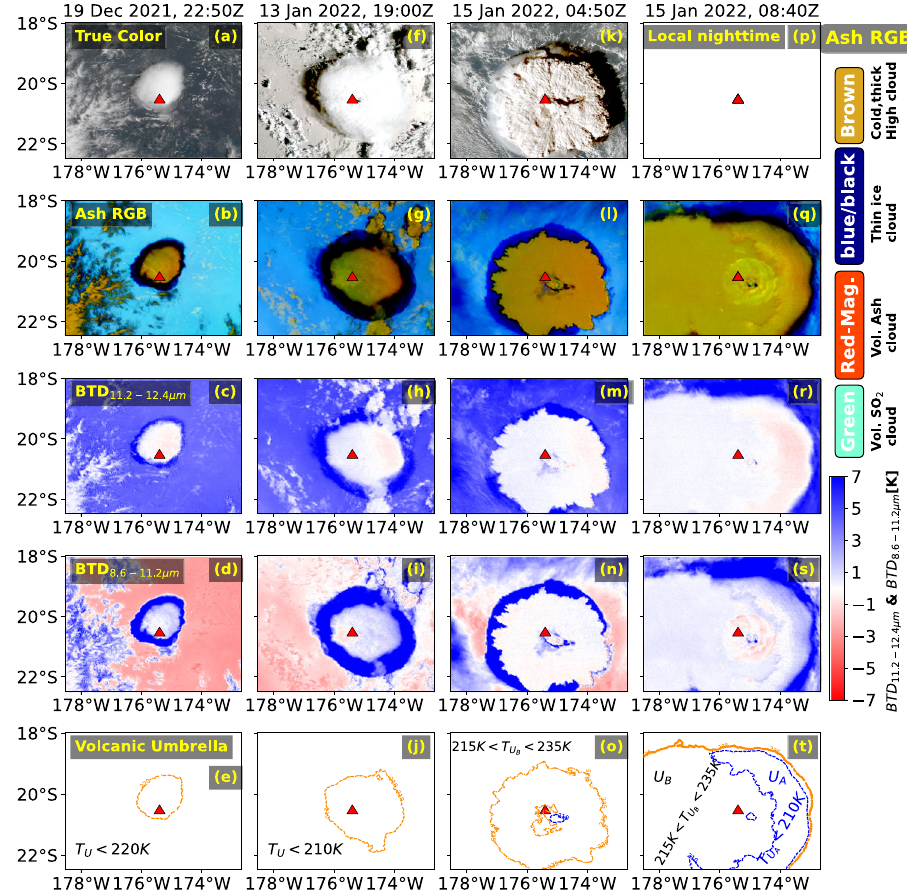
Fig. 3 Visible and thermal maps revealing umbrella cloud features. a Himawari-8 observed true color RGB centered around HTHH (175.38°W, 20.57°S) submarine volcano on 19 December 2021 at 22:50 UTC. Panel ( f ), and ( k ) are similar to panel ( a ) but for 13 January 2022 at 19:00 UTC, 15 January 2022 at 04:50 UTC, respectively. Panel ( p ) is same as panel ( k ) but at 08:40 UTC. Also, there are no re fl ectance data during local nighttime at 08:40 UTC. Panel ( b , g , l , q ) same as ( a , f , k , p ) but for Ash RGB. c Himawari-8 observed brightness temperature difference between 11.2 – 12.4 μ m (BTD 11.2 – 12.4 μ m ) on 19 December 2021 at 22:50 UTC. Panel ( h ), ( m ) and ( r ) are similar to panel ( c ) but for 13 January 2022 at 19:00 UTC, 15 January 2022 at 04:50 UTC, 15 January 2022 at 08:40 UTC, respectively. Panel ( d , i , n , s ) same as ( c , h , m , r ) but for brightness temperature difference between 8.6-11.2 μ m (BTD 8.6 – 11.2 μ m ). e The contour level extracted using a histogram technique (see Methods) on 19 December at 2250 UTC. j Same as ( e ) but for 13 January 19:00Z at contour level 210 K. o same as ( e ) but for 15 January at 04:50 Z at 215 K < T U < 240 K. t Same as ( o ) but at 08:40 Z and for two contour levels B (215 K < T U < 240 K and T U < 210 B A